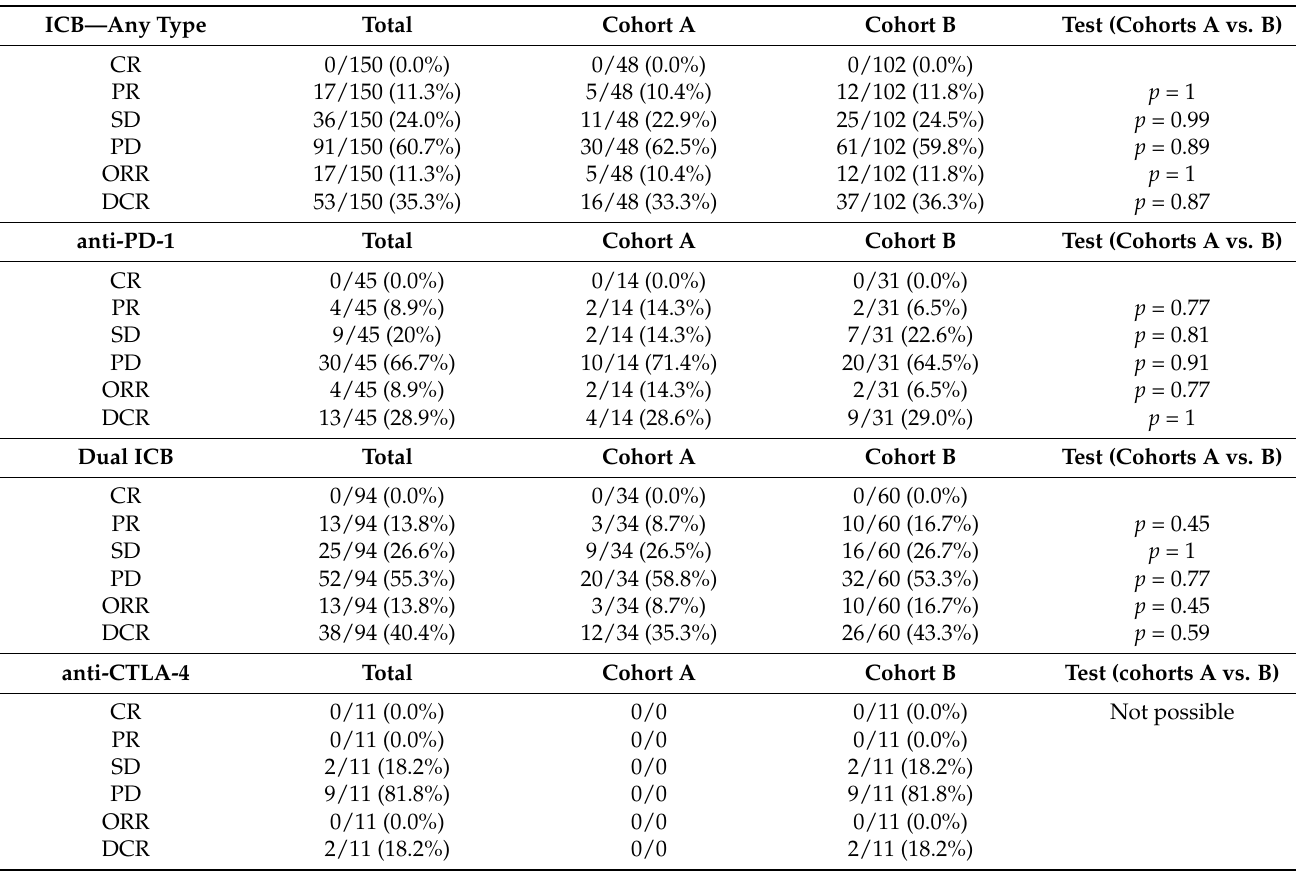
Table 2. Response rates to ICB according to ICB substance. Abbreviations: CR = complete response, PR = partial